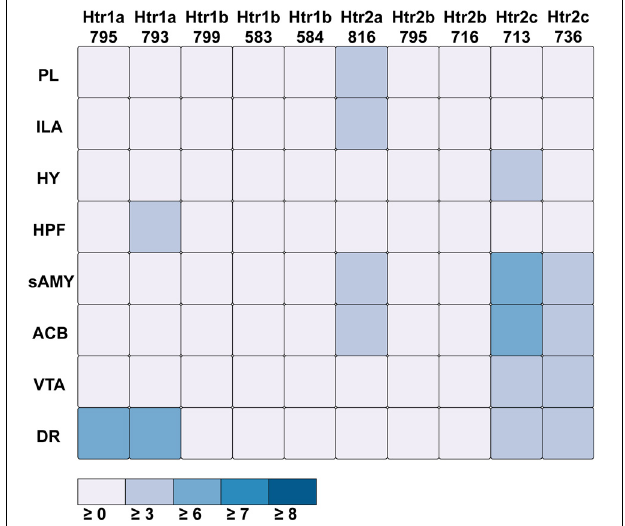
FIGURE 7 | ABADV Heatmap of Serotonin Receptor Genes in Brain Structures Associated with Reward Processing. Each cell in the matrix represents an expression energy value for a particular experiment (column) and brain structure (row). The shade of the color denotes how much expression was found in that cell, where the darker the color, the higher the expression, and the lighter the color, the lower the expression.